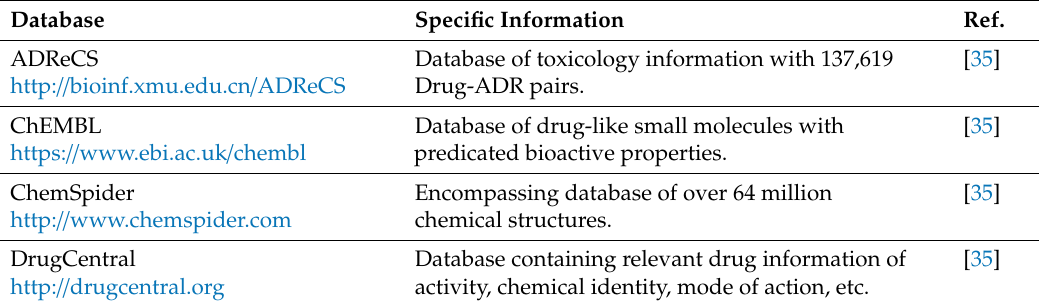
Table 3. Databases used for lead discovery, optimization, and